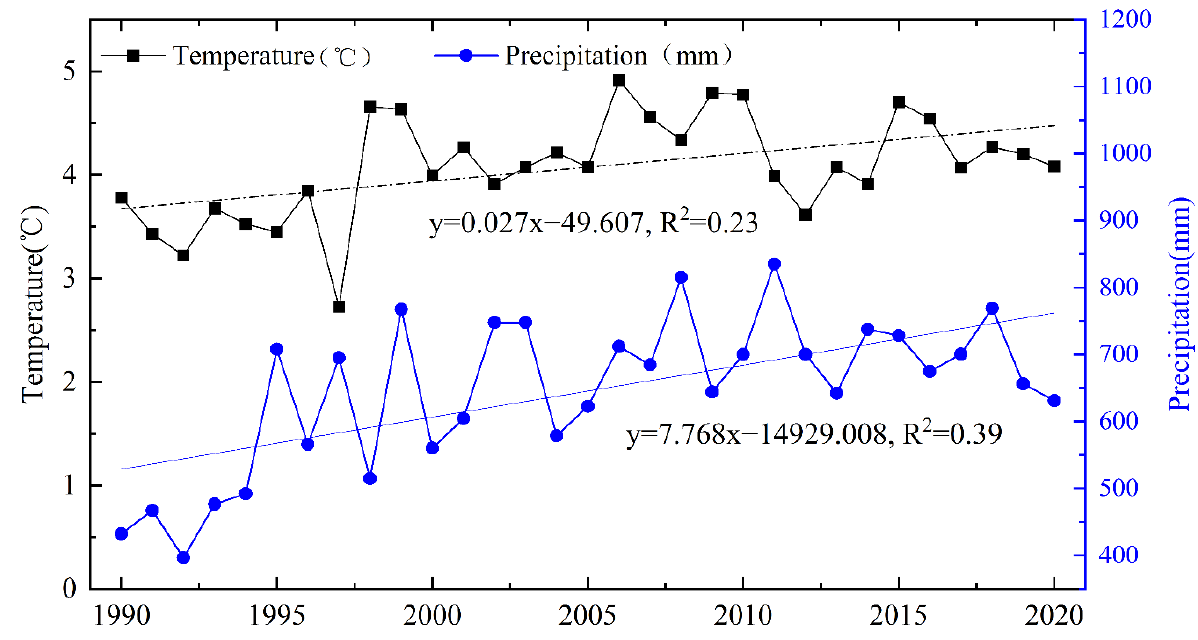
Figure 11. The changes in annual air temperature and precipitation in Nyalam County during 1990–2020. Table 4. Depth data at validation